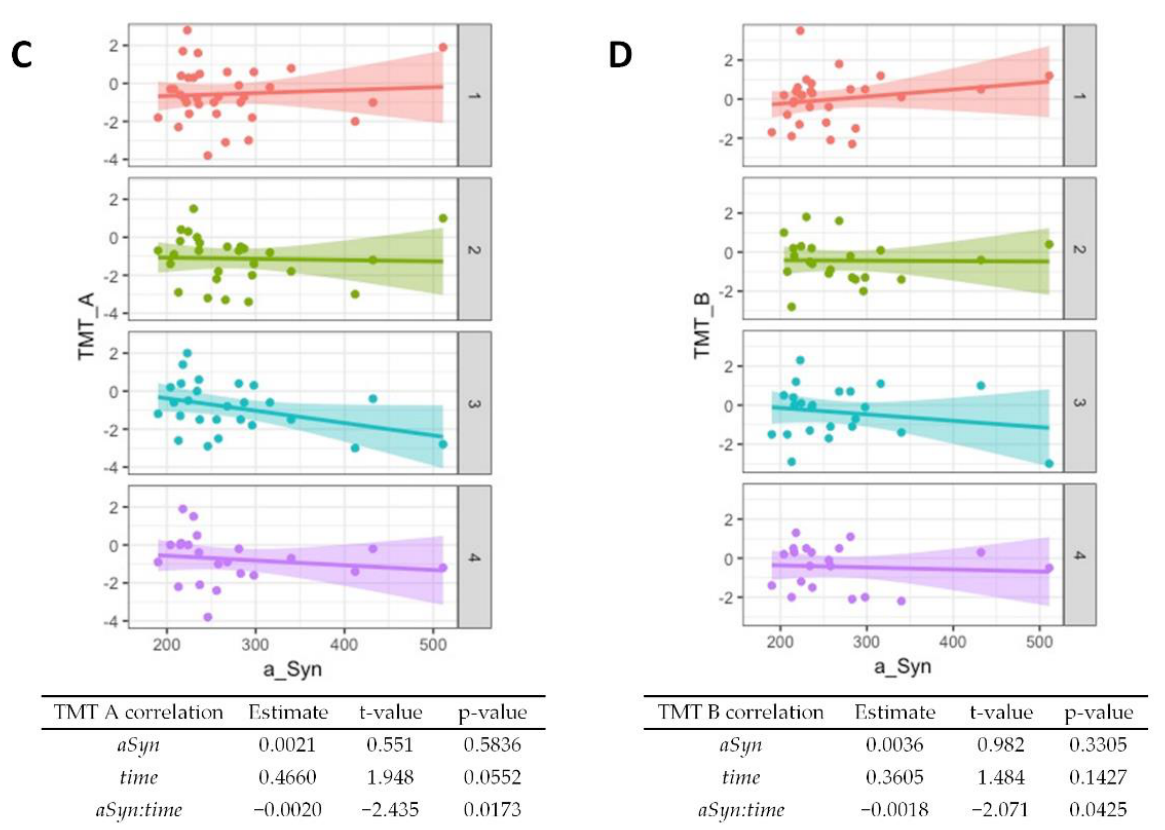
Figure 3. Association of α -synuclein with cognitive test performance. Correlations from mixed linear regression are displayed through scatter plots with regression lines at baseline (1, red plot), 6 months (2, green plot), 12 months (3, turquoise plot), and 24 months (4, purple plot). Estimates, t-values, and p -values refer to the correlation of results from the Boston Naming Test (BNT) ( A ), Semantic verbal fluency (SemFlu) ( B ), Trail Making Test A (TMT A) ( C ), and Trail Making Test B (TMT B) ( D ) with α -synuclein ( α Syn ), changes over time ( time ), and to the correlation of baseline CSF α -synuclein with changes in stage/score over time ( α Syn:time )